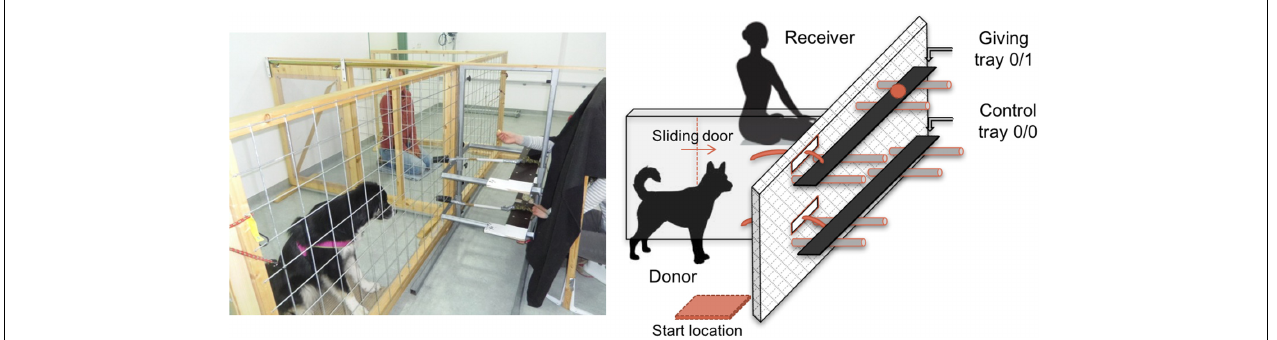
FIGURE 1 | Side view of the experimental